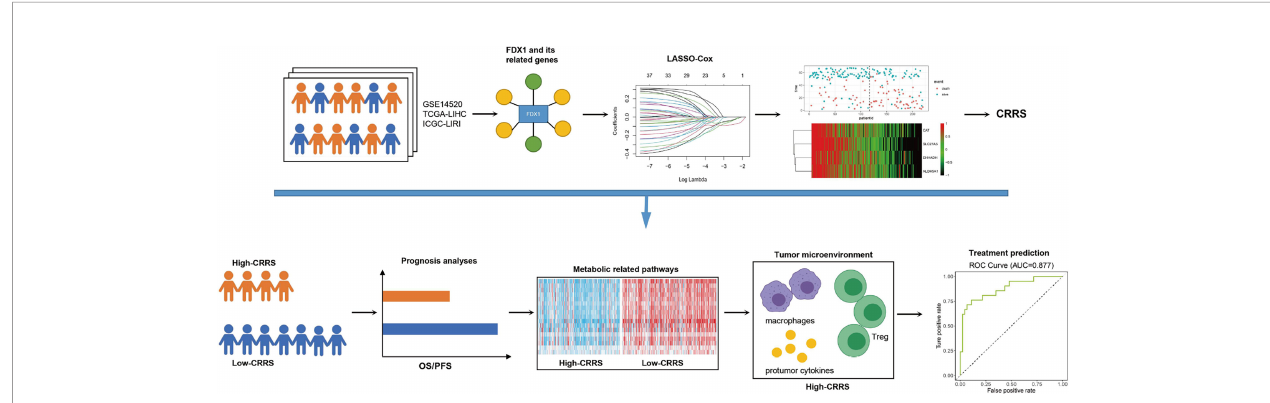
FIGURE 8 | Summarization of this study. FDX1 and its 36 related genes were identi fi ed in the HCC datasets. A novel quanti fi ed index, the CRRS, was constructed using the LASSO Cox regression model. HCC patients with high CRRS showed shorter survival time, lower enrichment in metabolic-related pathways, and high in fi ltration of protumor immune in fi ltrates. In addition, CRRS exhibited a good capability in predicting the responsiveness to sorafenib and the non-responsiveness to